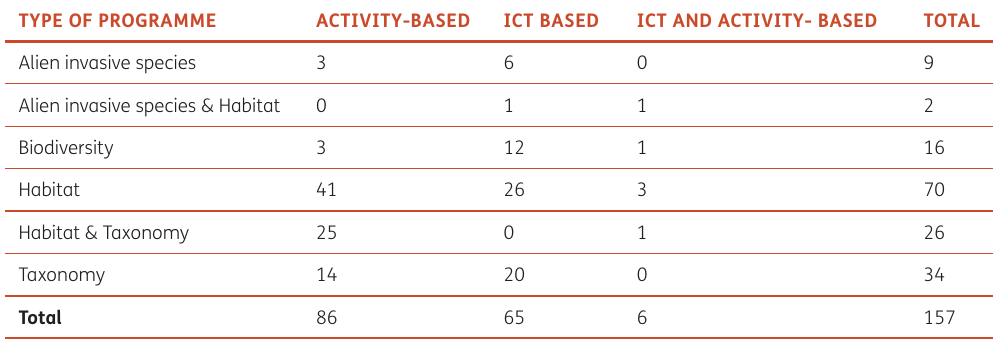
Table 1 Summary of activity-based (focused) and Information Communication Technology (ICT) (broadscale) aquatic citizen science programmes (n = 157).